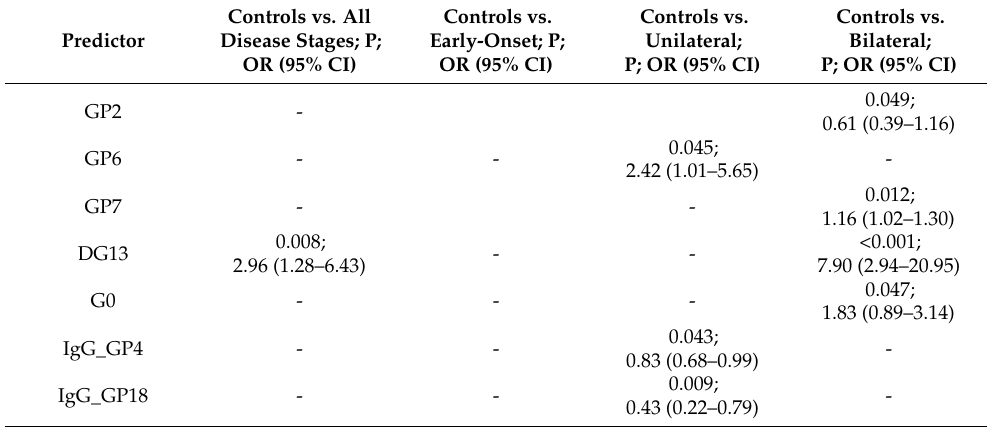
Table 3. The results of multinomial logistic regression; only the significant results of the terminal step are